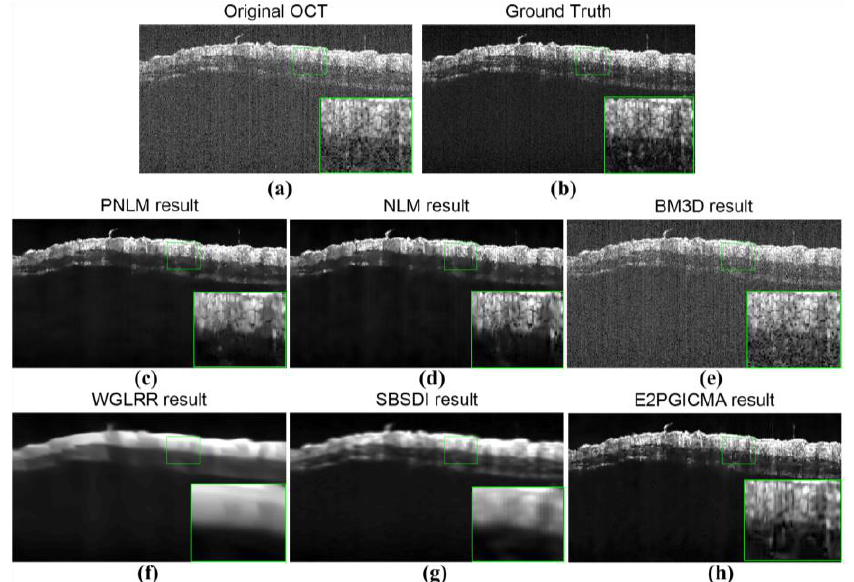
Figure 5. Speckle noise reduction with the different methods. ( a ) The original OCT image of normal mouse skin in vivo. ( b ) The ground truth is made with the averaged value of five OCT images with OCT scanning at the same location. ( c – h ) The OCT images and enlarged ROIs with these different noise-reduction methods corresponding to the PNLM, NLM, BM3D, WGLRR, SBSDI and E2PGICMA methods.